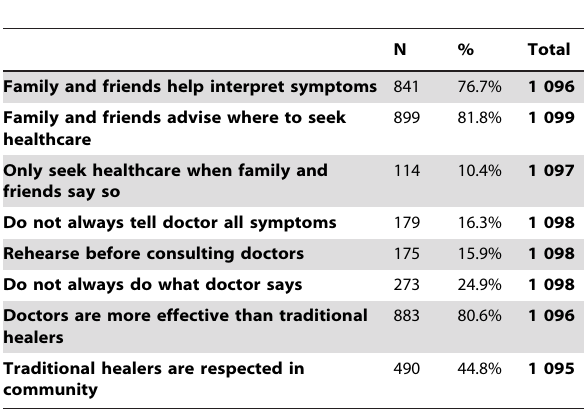
Table 4. Health-seeking